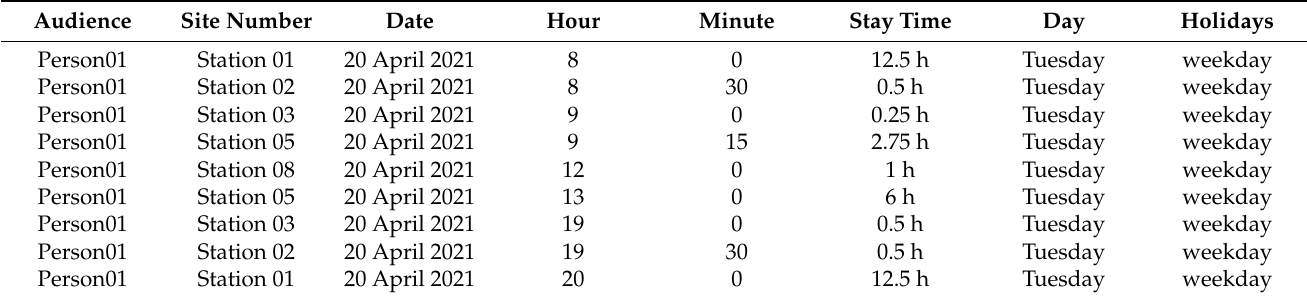
Table 6. Advanced time characteristics of specific